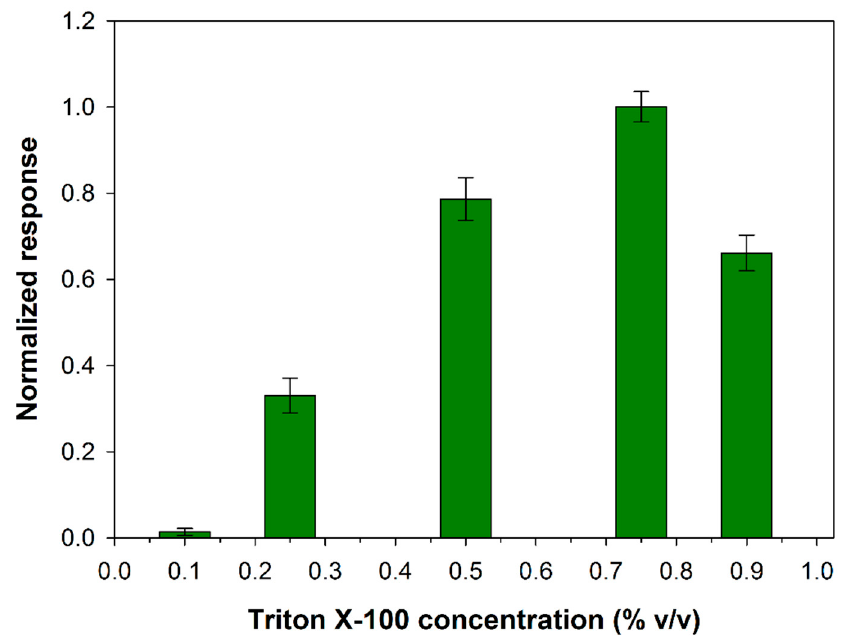
Figure 1. Normalized response (i.e., response/maximum response) of a typical Pt/PPyox/ChO biosensor to PLD 0.22 IU/mL as a function of Triton X-100 concentration. Supporting electrolyte: Tris buffer pH 8.0, I 0.05 M containing 10 mM calcium chloride, and 5 mM phosphatydylcholine. Electrode rotation rate: 1000 rpm.